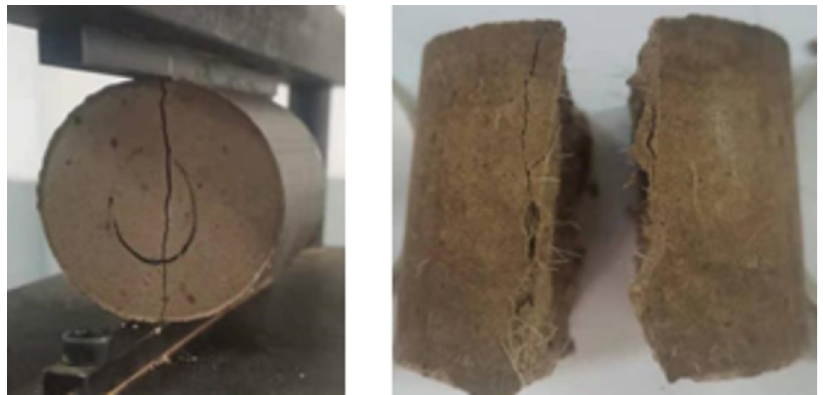
Fig 8. Indirect tensile strength test specimen. Under the action of static load, the failure of specimen shows three processes: initial crack generation, crack propagation, new crack generation and fiber pulling out. After cracking, crack development and fiber pulling out will be carried out